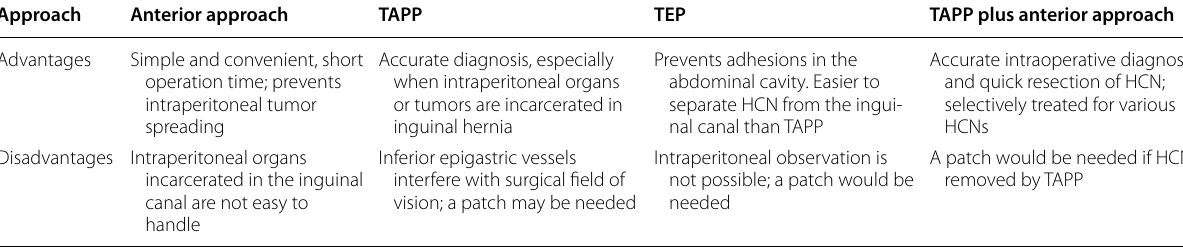
Table 1. The advantages and disadvantages of various surgical approaches